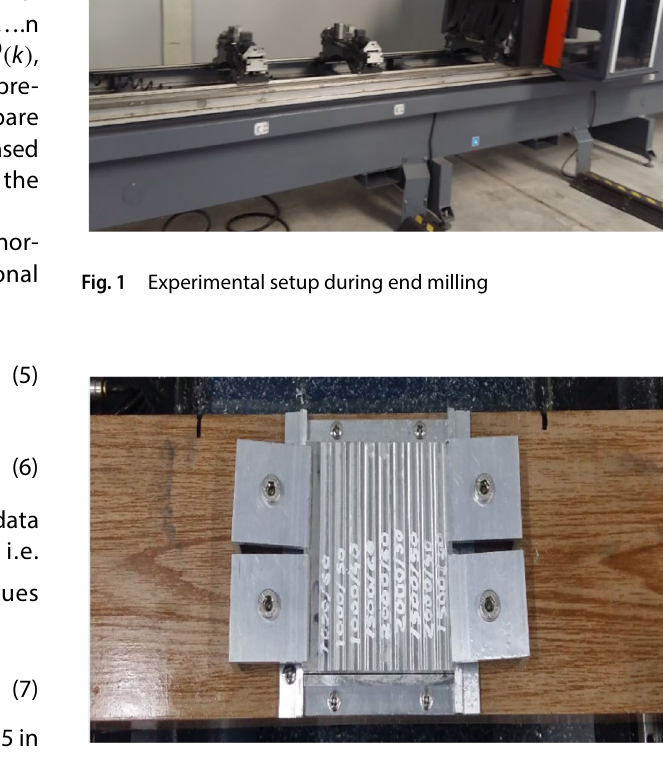
Fig. 2 Clamp set up for holding the work